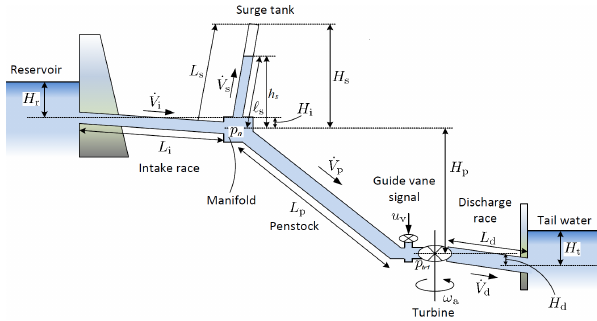
Figure 1: Overview of the structure of the high head hydropower